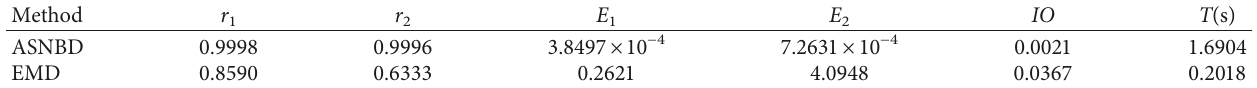
1 ( n ) generated by ASNBD and EMD.